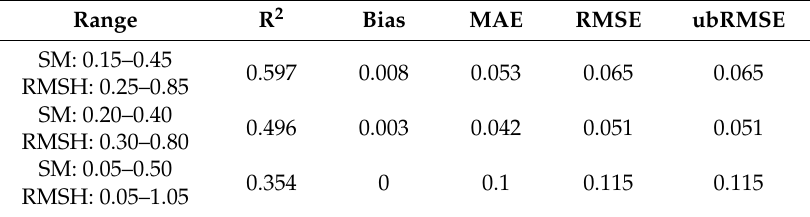
Table 5. Influence of initial range on soil moisture retrieval accuracy. The retrievals are based on the SCA-VV scheme, with VWC estimated using NDWI_865–1614 and parameter values for “all land uses” employed (i.e., the best performing scenario). SM denotes soil moisture. Range R